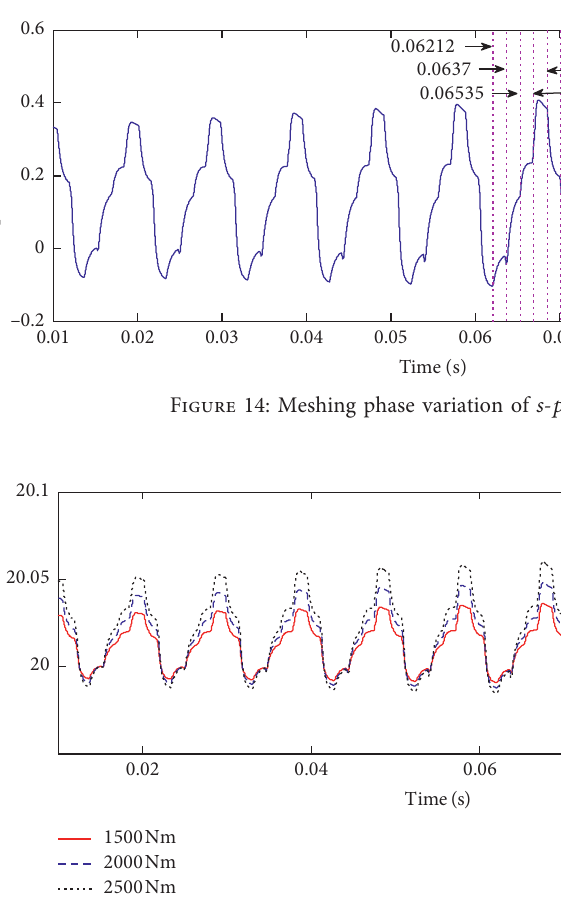
Figure 15: Pressure angle of s- p